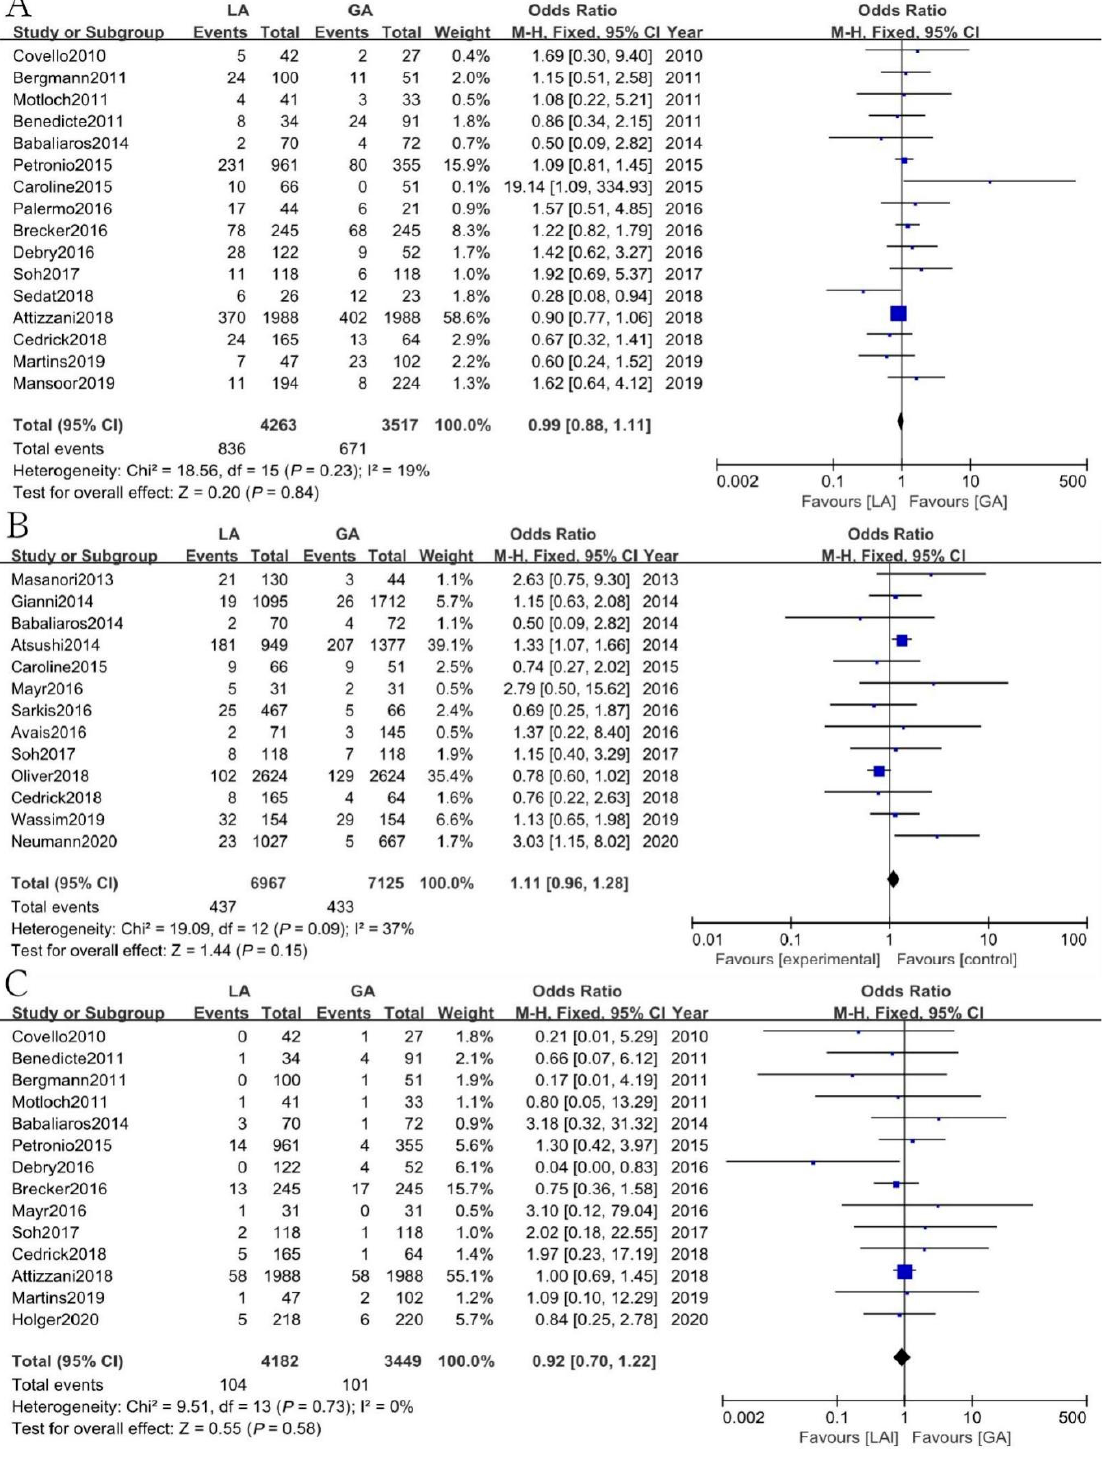
Figure 5. Forest plot of ( A ) permanent pacemaker implantation rate. ( B ) Paravalvular leakage. ( C ) Shock. Green symbols: continuous data; blue symbols: dichotomous data; black symbols: other type data.